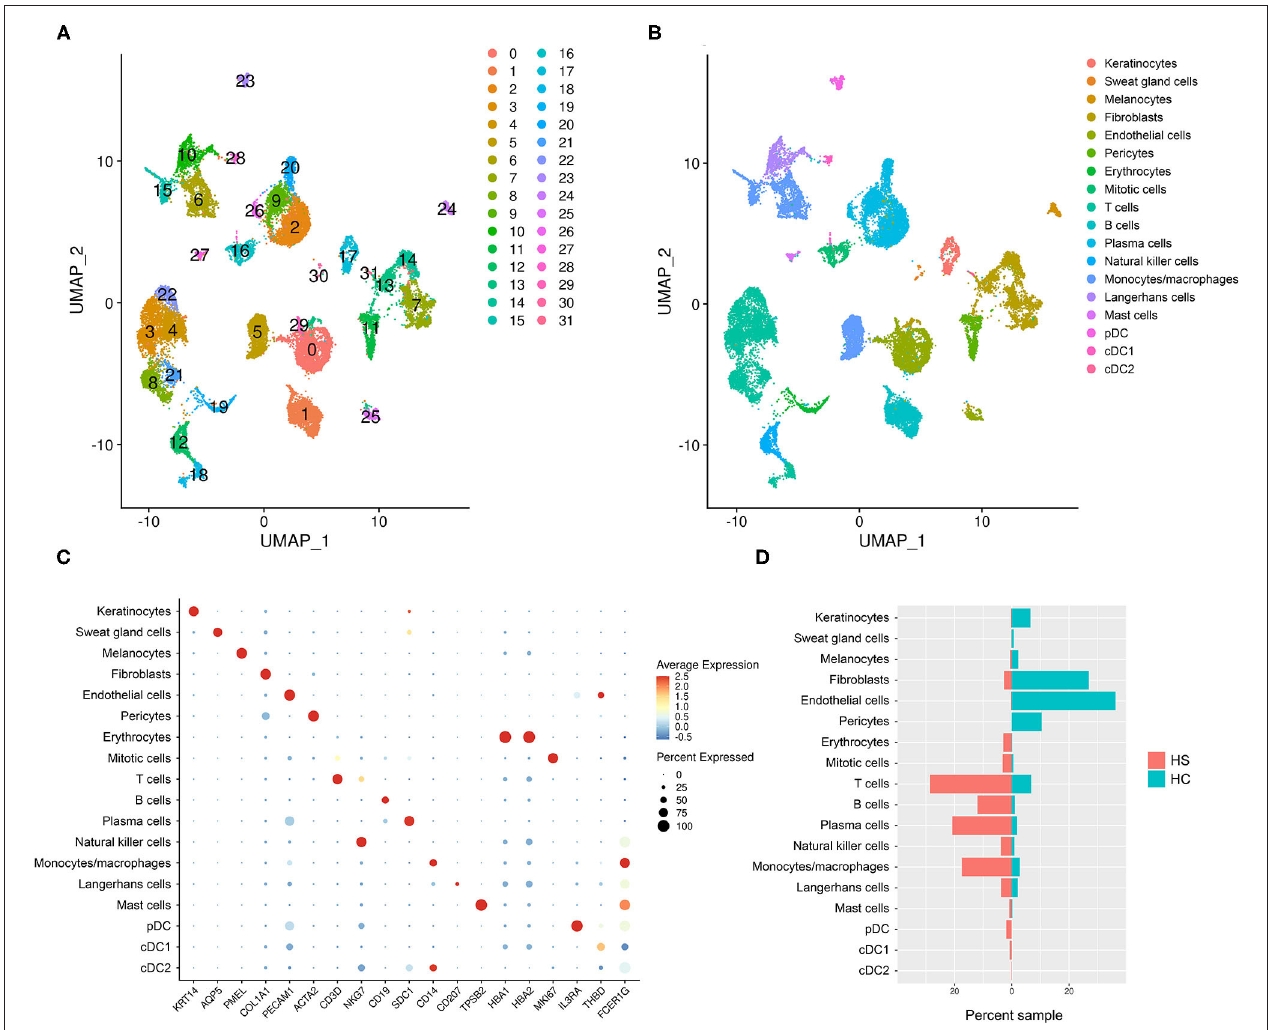
FIGURE 2 | scRNA-sequencing reveals a relative abundance of immune cells in HS skin lesions. (A) Unsupervised clustering represented in a UMAP plot of skin samples collected from 3 patients with HS and 1 HC. (B) UMAP plot of clusters grouped by cellular identity. (C) Dot plot of the percent expressed and average expression of signature genes for clusters grouped by cellular identity. (D) Sample distribution of cell populations by percent of total sample organized by whether they came from HS or HC skin. cDC, conventional dendritic cell; HC, healthy control; pDC, plasmacytoid dendritic cell. “Mitotic cells” were defined as KI67-expressing cells in the mitotic phase of the cell